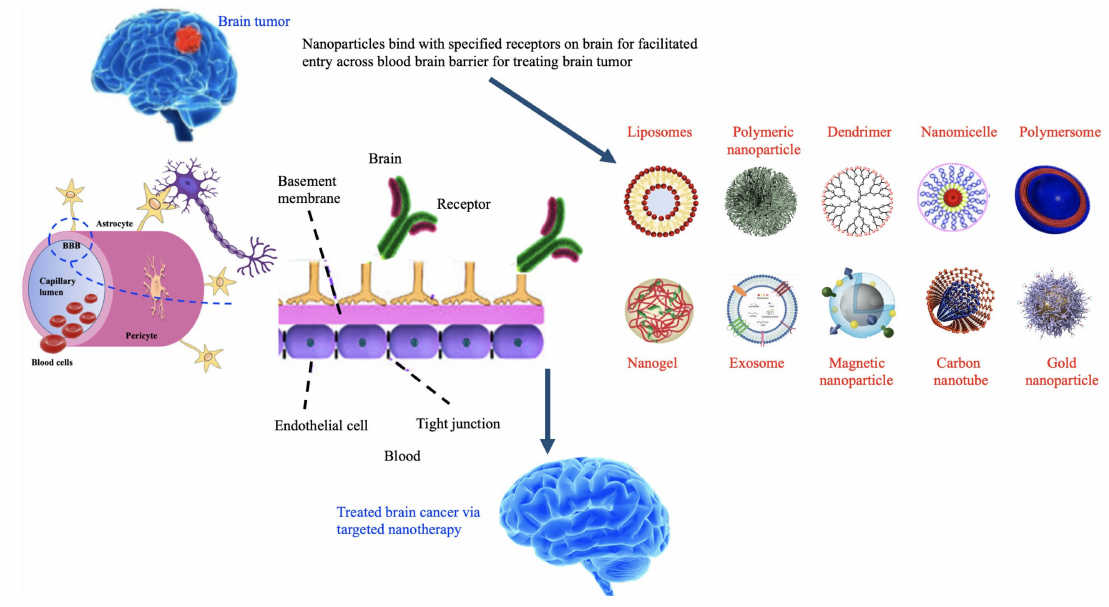
Figure 1. Brain cancer treated with novel nanoparticle (NP)